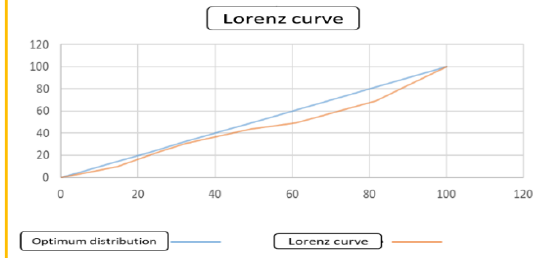
Fig. 3. Lorenz curve for drinking water services / neighborhood of al-ameer, source: researcher based on previous